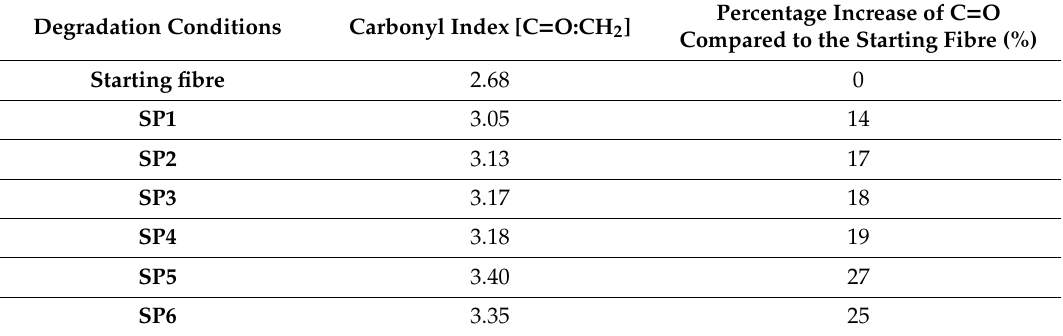
Figure 12. FTIR spectra of PA66 microfibres before (blank) and after the treatment (SP1-SP6) with di ff erent conditions of UV and TiO 2 . SP1 = deionised water; SP2 = deionised water + TiO 2 ; SP3 = deionised water + UVA; SP4 = deionised water + UVA + TiO 2 ; SP5 = deionised water + UVC; SP6 = deionised water + UVC + TiO 2 . a.u—arbitrary units. Table 6. Carbonyl index (CI) of unexposed PA66 microfibres (starting fibres) and PA66 microfibres exposed to di ff erent UV and TiO 2 conditions (SP1 to SP6) for 105